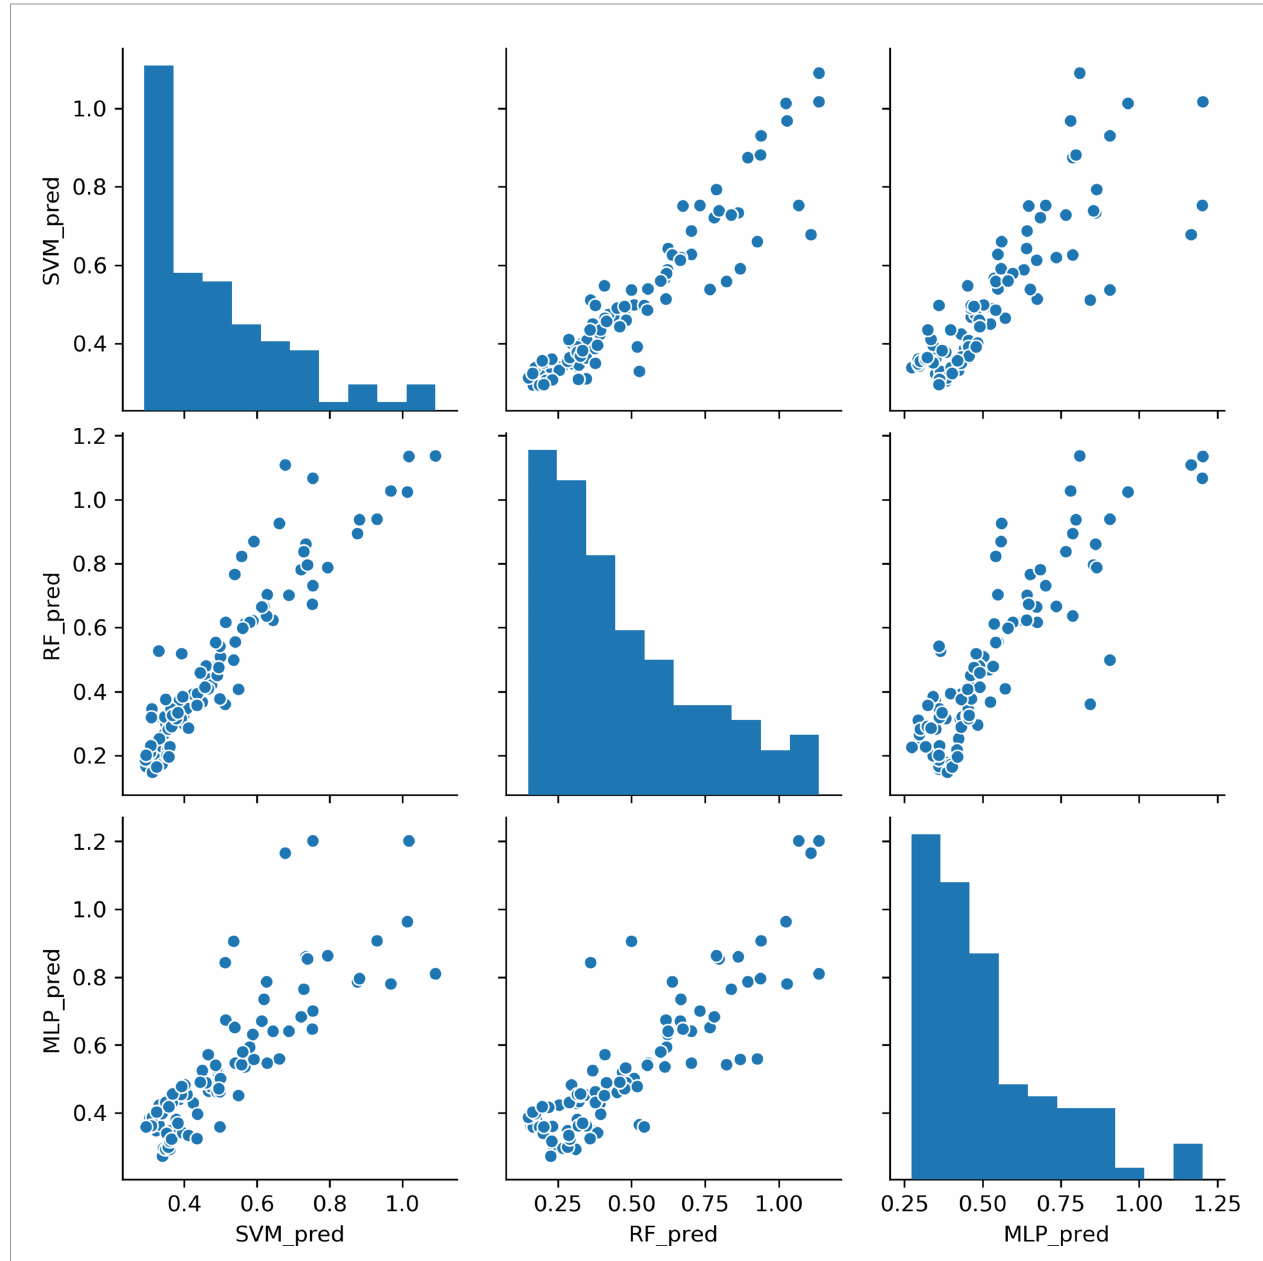
FIGURE 2 | Comparisons of CD4/CD8 ratio predictions for the three machine learning models. Each point represents a sample. SVM, support vector machine; RF, random forest; MLP, multi-layer